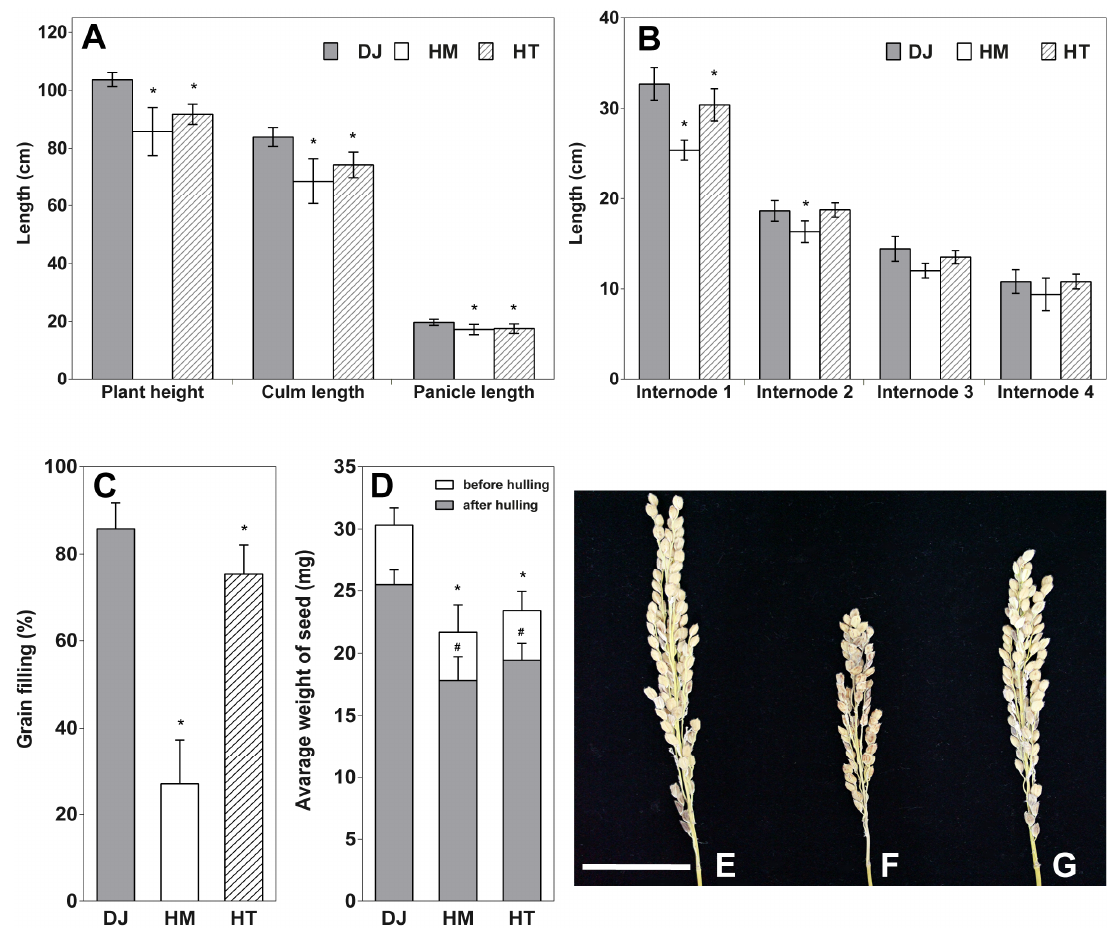
Figure 2. Morphological and reproductive phenotype of the Osfuct HM mutant and HT plant compared to Dongjin (DJ) under field conditions. ( A ) Comparison of plant height, culm length and panicle length among the DJ, HM and HT lines ( n = 4). ( B ) Comparison of internode lengths among the DJ, HM and HT lines ( n = 4). ( C ) Comparison of grain filling among the DJ, HM and HT lines ( n = 4). ( D ) Comparison of average weight of 30 seeds among the DJ, HM and HT lines ( n = 4). ( E ) Panicle phenotype of DJ. ( F ) HM. ( G ) HT lines. Scale bar is 4 cm. Data are mean ± standard deviation (SD). Asterisk indicates significant differences compared with wild type (* p < 0.05 by Student’s t -test).